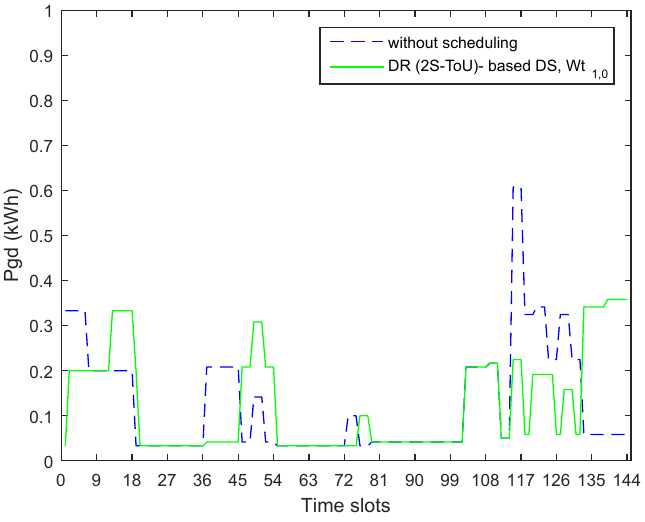
Figure 9. Load profile with maximal reduction in CE for 2S-ToUP